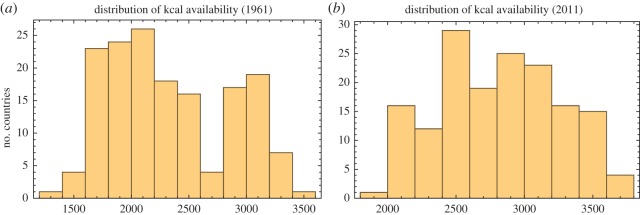
Convergence in food security: the distribution of kcal availability was bimodal in (a) 1961 but became unimodal by (b) 2011. This is consistent with a decrease in the cross-sectional standard deviation, see figure 2.